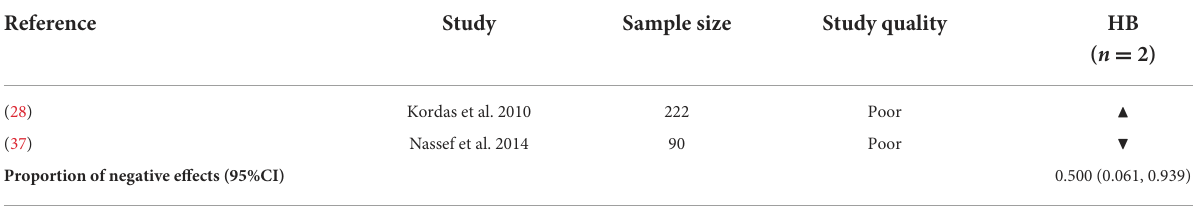
TABLE 3 Vote counting based on the direction of effect between cadmium concentration and red blood cell parameters.